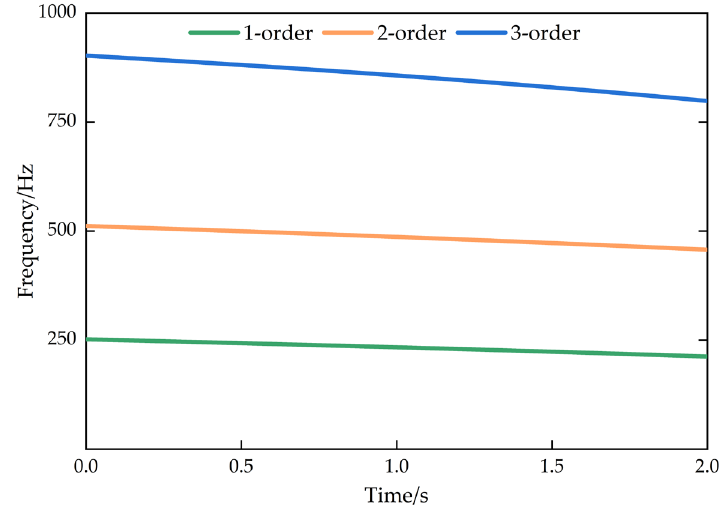
Figure 5. Natural frequencies of the 3-DOF time-varying structure.